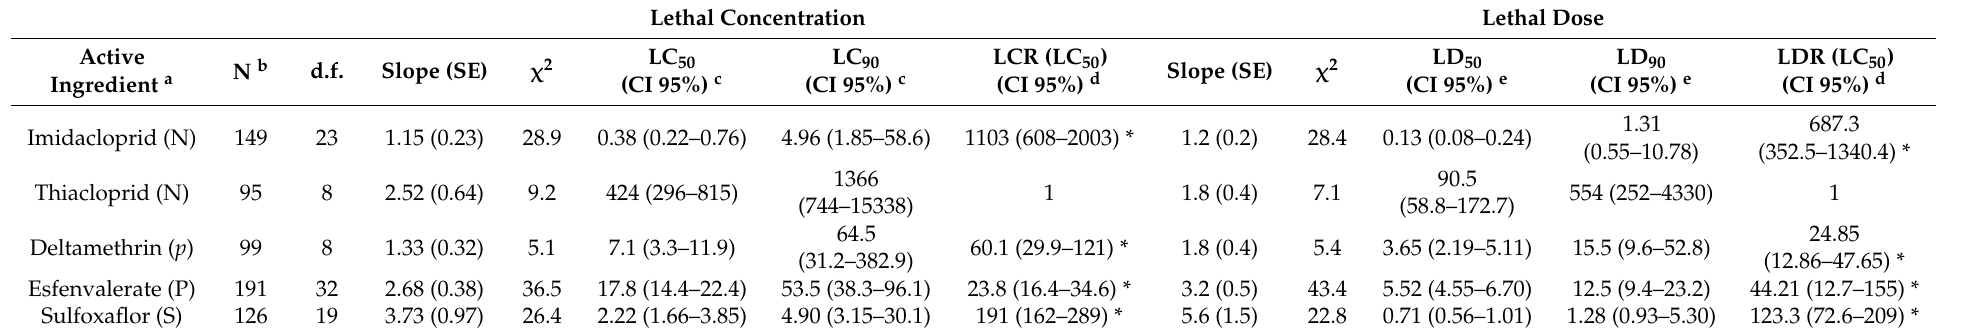
Table 1. Toxicity of insecticides with different mode of action on B. terrestris workers after 48 h oral exposure. Data expressed as lethal concentration (LC) or lethal dose